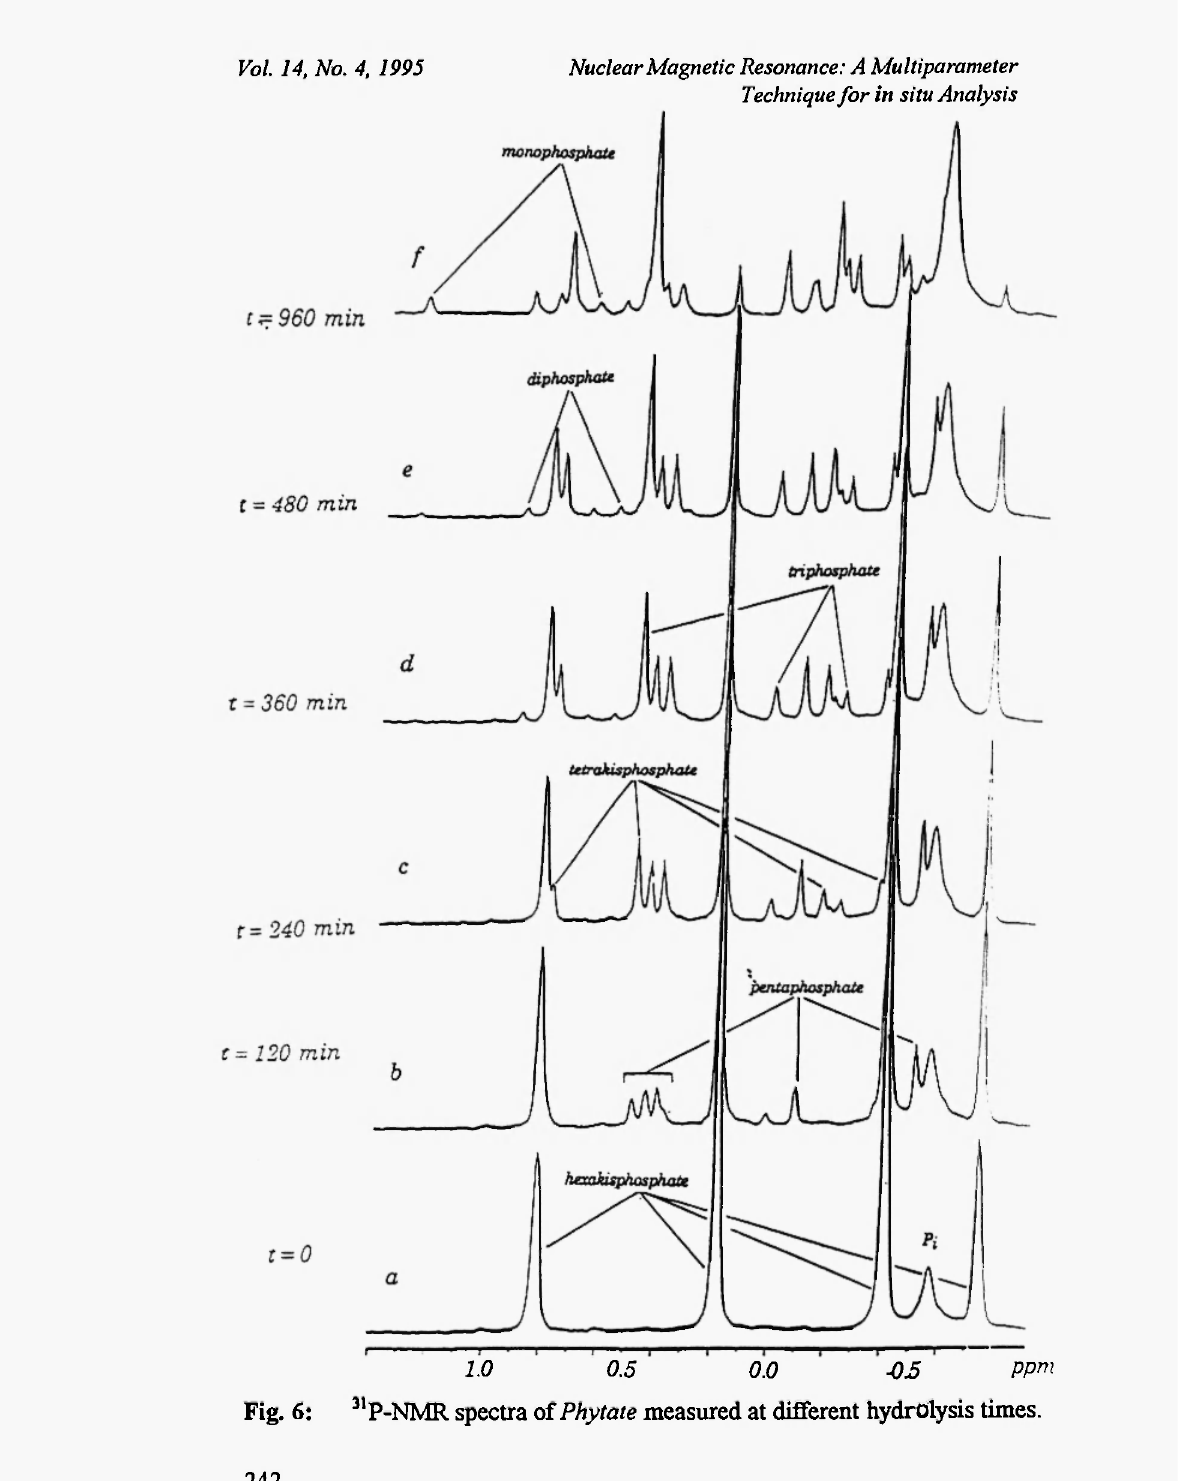
31 P-NMR spectra oiPhytate measured at different hydrolysis